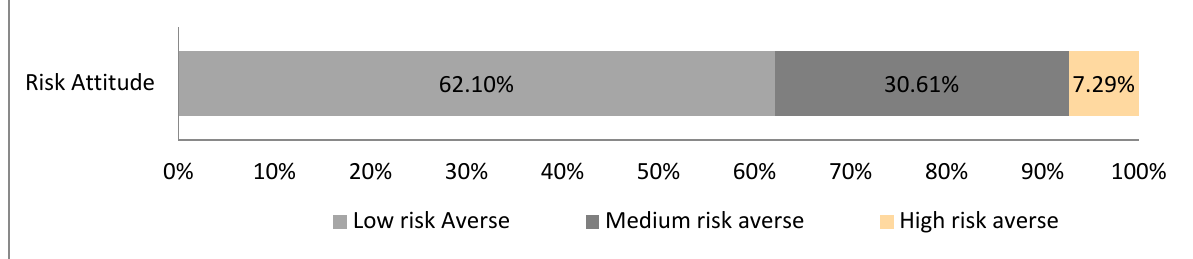
Table 3. Factor analysis output for input risk management